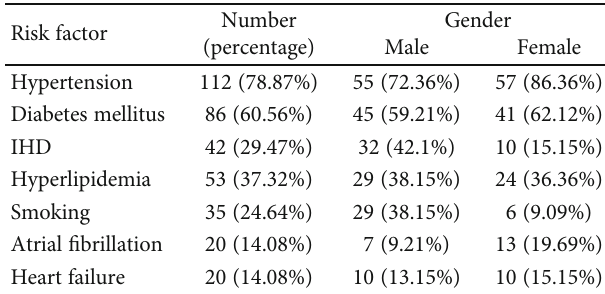
Table 1: Stroke risk factors and their distribution by sex. Abbreviations: ischemic heart disease: IHD.